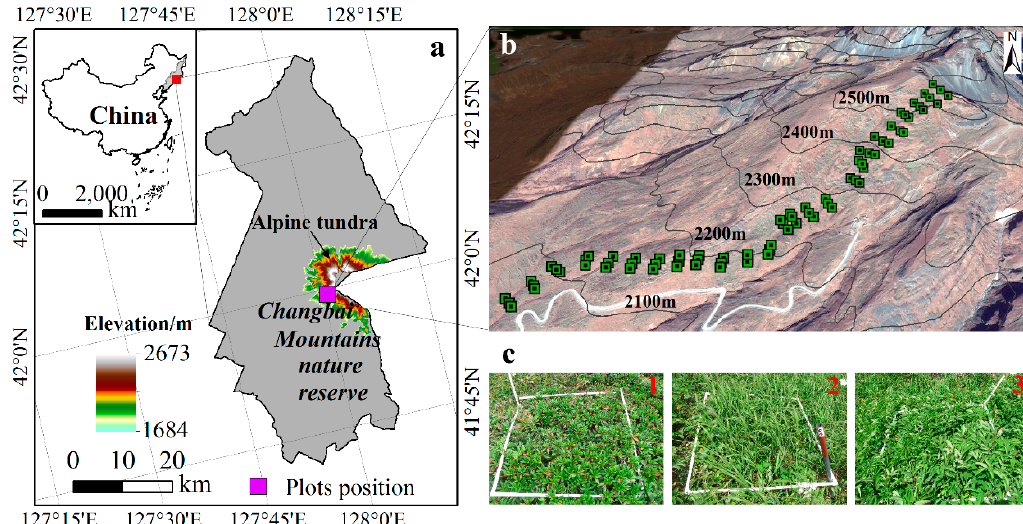
Figure 1. Map to show the location of alpine tundra plots along the western slope of the Changbai Mountains ( a , b ). The dominant plant species ( R. chrysanthum ( c1 ), D. angustifolia ( c2 ), and Sanguisorba sitchensis CA Mey. ( c3 )) on alpine tundra.